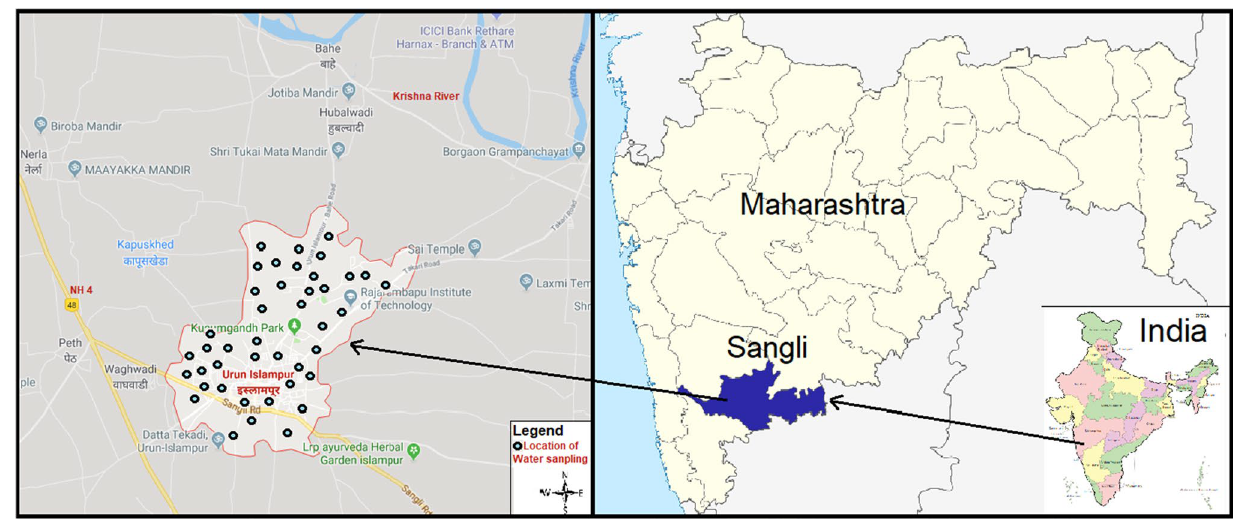
Fig. 1 Study area. Sources : Google Maps